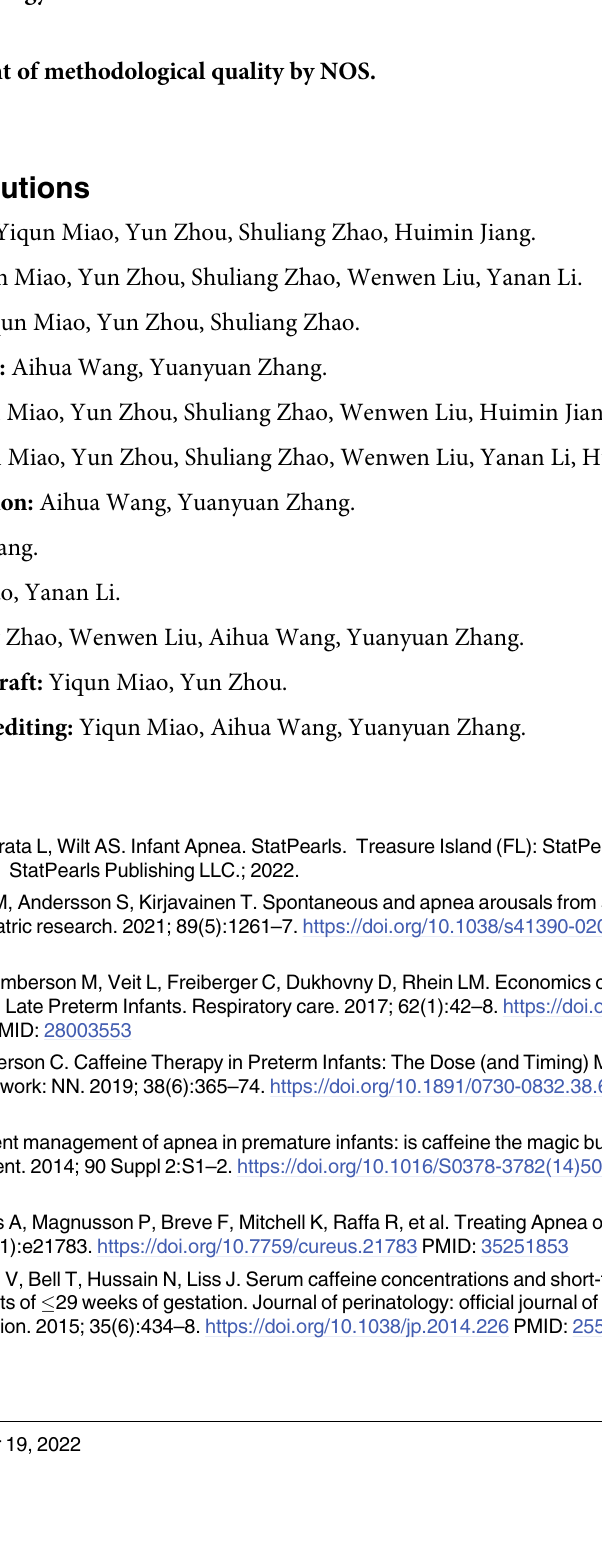
S1 Table. PRISMA checklist. S2 Table. Search strategy. S3 Table. Assessment of methodological quality by